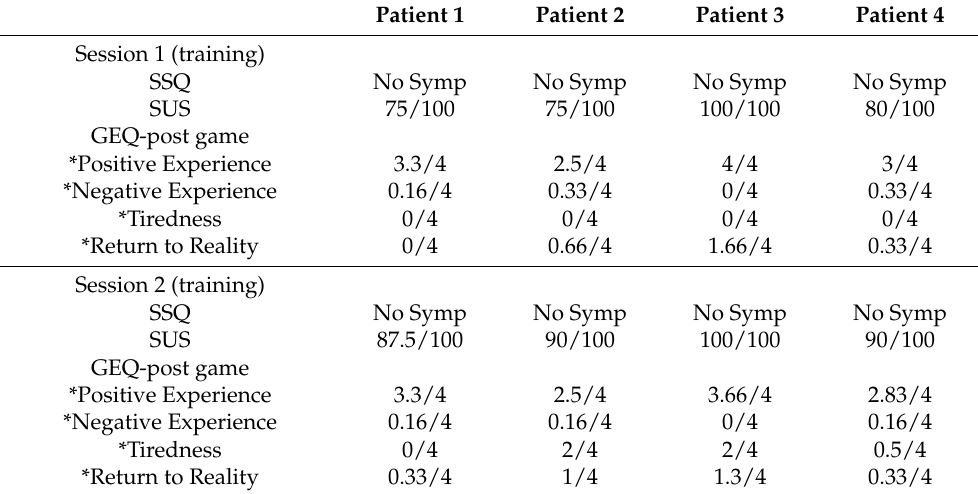
Table 2. Results of IVR training